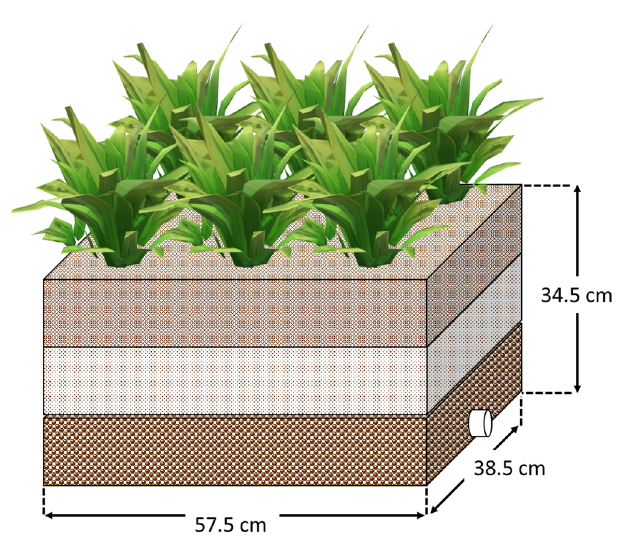
Figure 1. Design of the constructed wetland